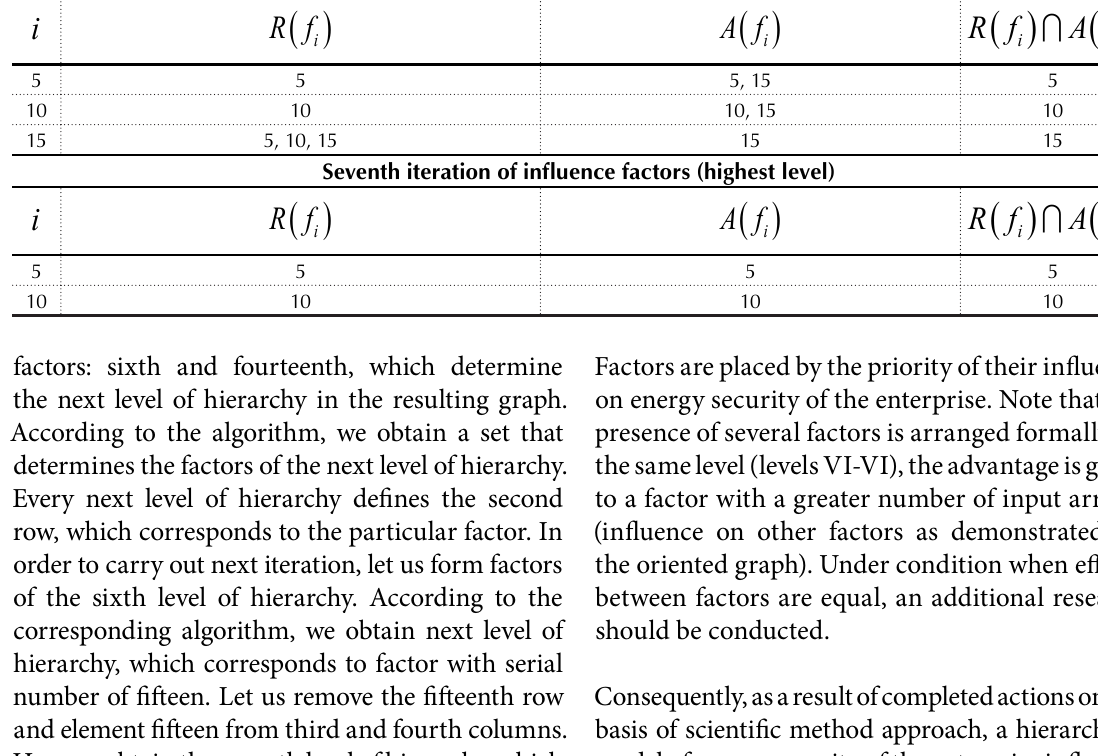
Table 2 (cont.). Sequence of iterations determining the hierarchy levels of factors influencing the energy security of the enterprise Sixth iteration of influence